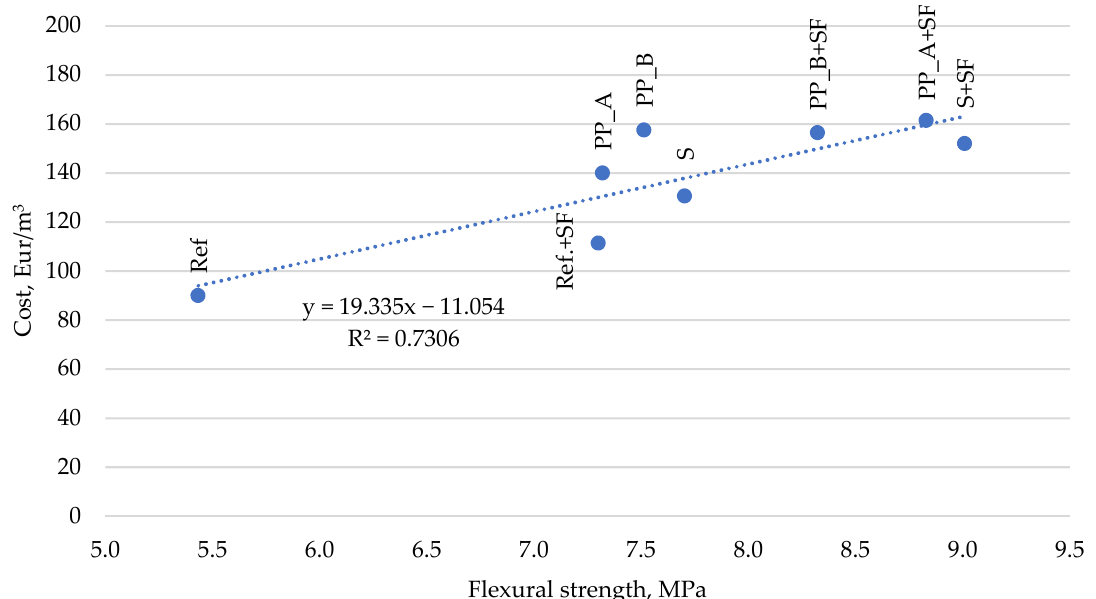
Figure 7. Cost of fresh concrete in terms of compressive strength.